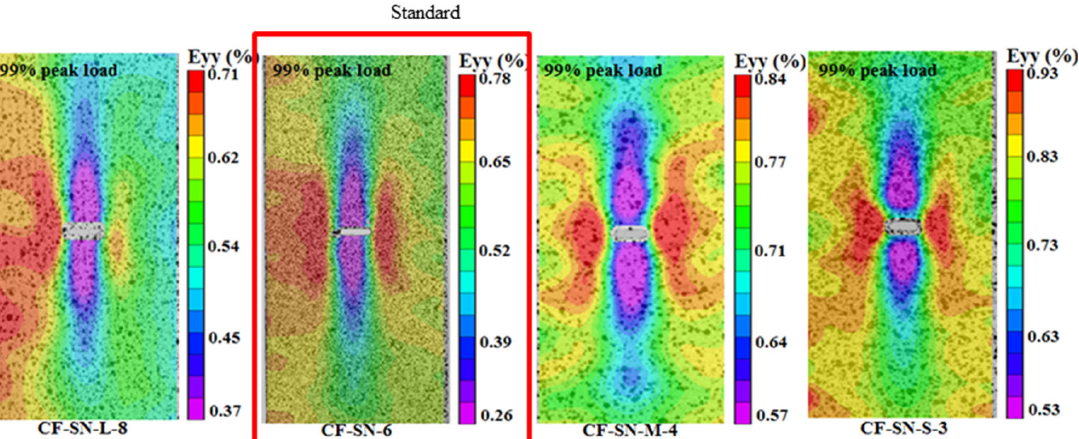
Figure 11. Strain field distribution of straight-notched specimens with the same ratio of W /2 C under a 99% ultimate tensile load; the strain concentration areas do not diffuse to the edge due to the concurrent enlargement of specimen size.